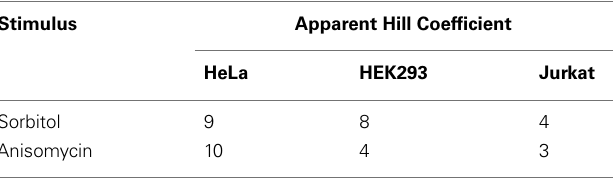
Table 2 | Ultrasensitivity of the JNK response to stress in mammalian cell populations (Bagowski et al.,